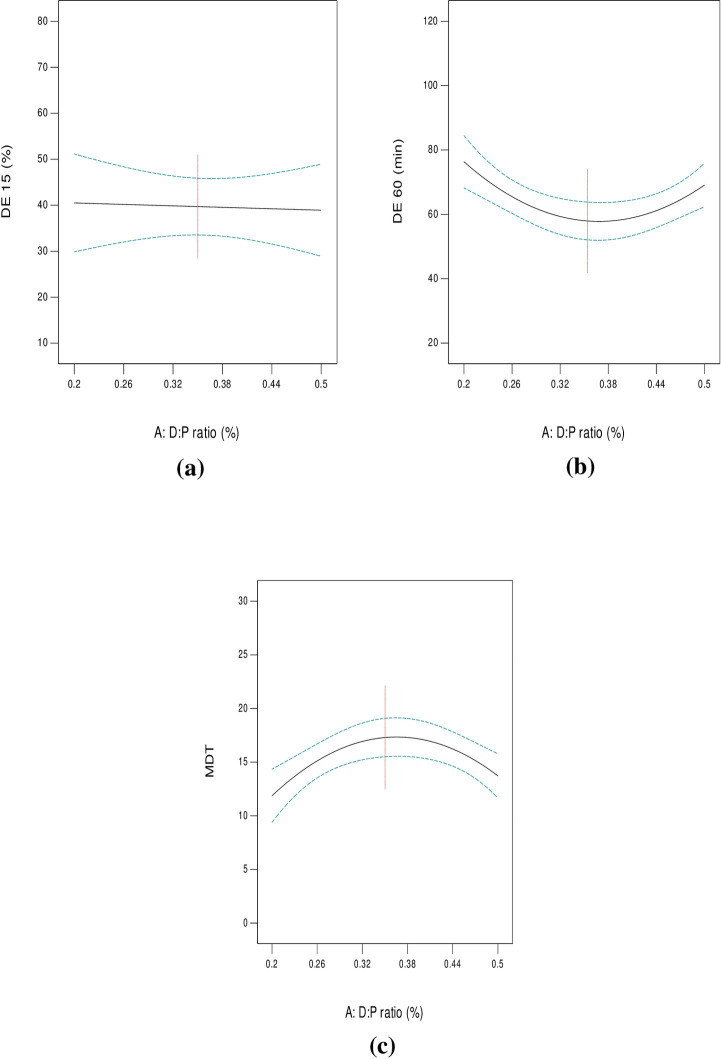
Line plots for the effect of D:P ratio on DE (15 min) % (a), DE (60 min) % (b) and MDT (c).